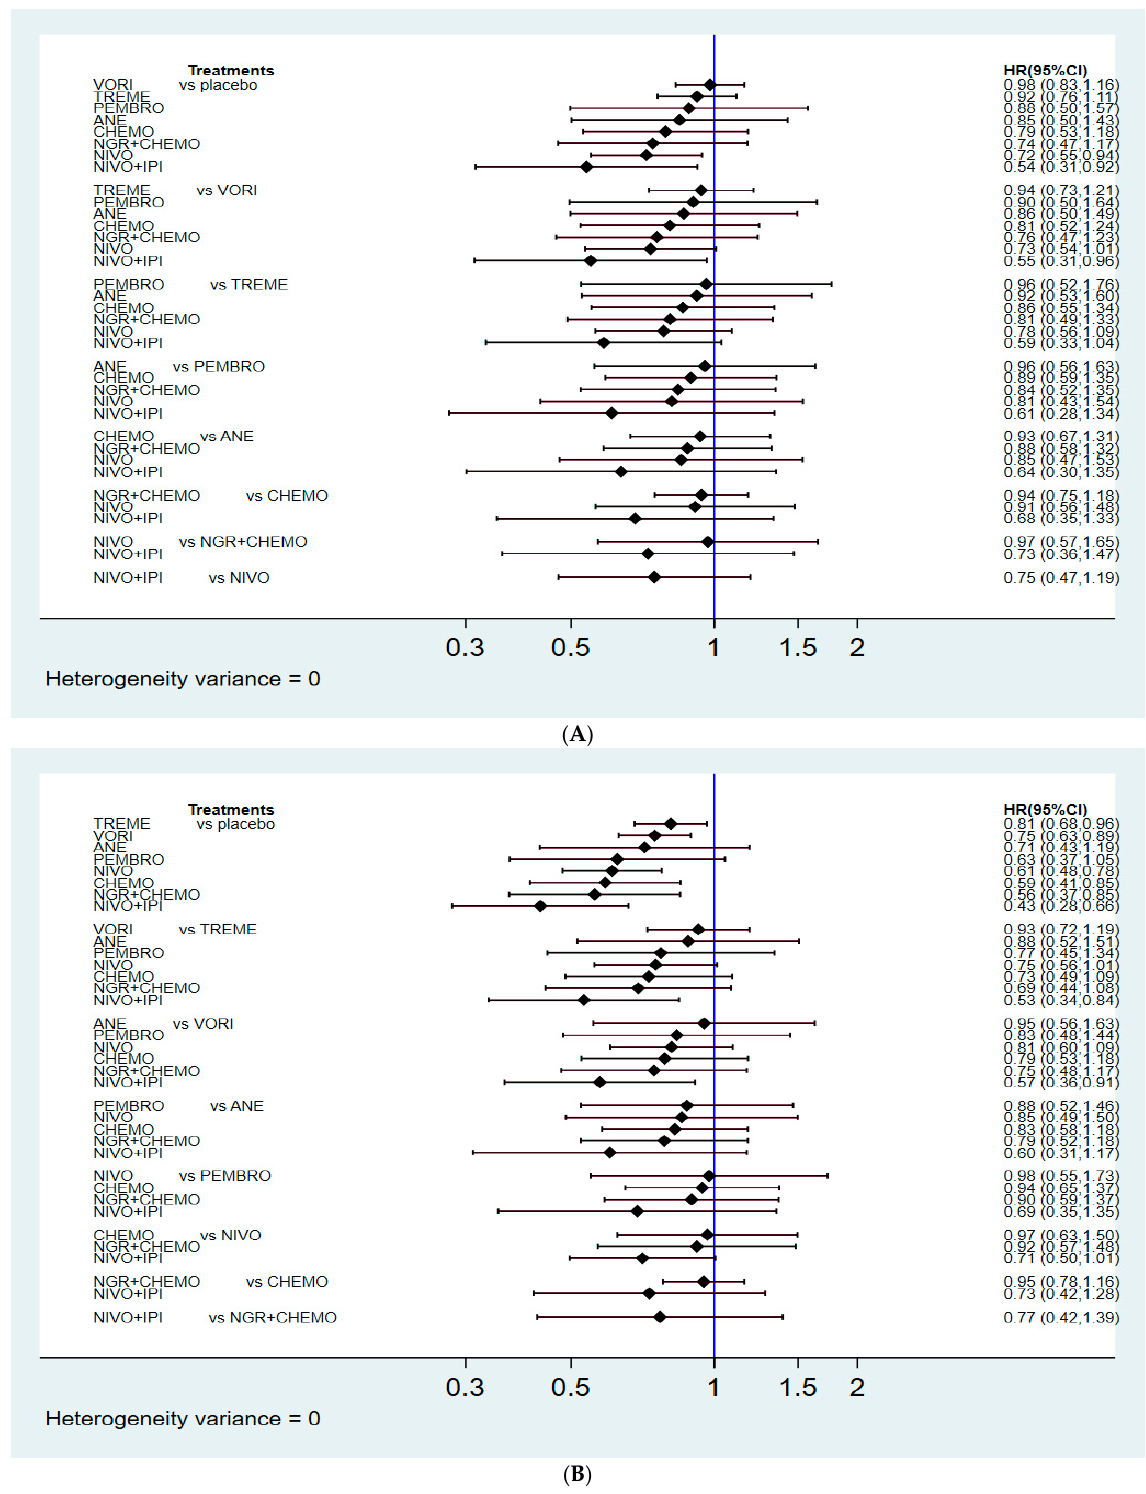
Figure 3. Summary of effect sizes based on pairwise comparisons. ( A ) Hazard ratios for overall survival (OS); ( B ) Hazard ratio for progression-free survival (PFS). The SUCRA rankings are shown in Figure 4A, indicating that nivolumab plus ip- ilimumab was associated with the best ranking for OS (SUCRA: 90.8%), followed by nivolumab (SUCRA: 69.8%), NGR-hTNF plus CTX (SUCRA: 66.4%), CTX (SUCRA: